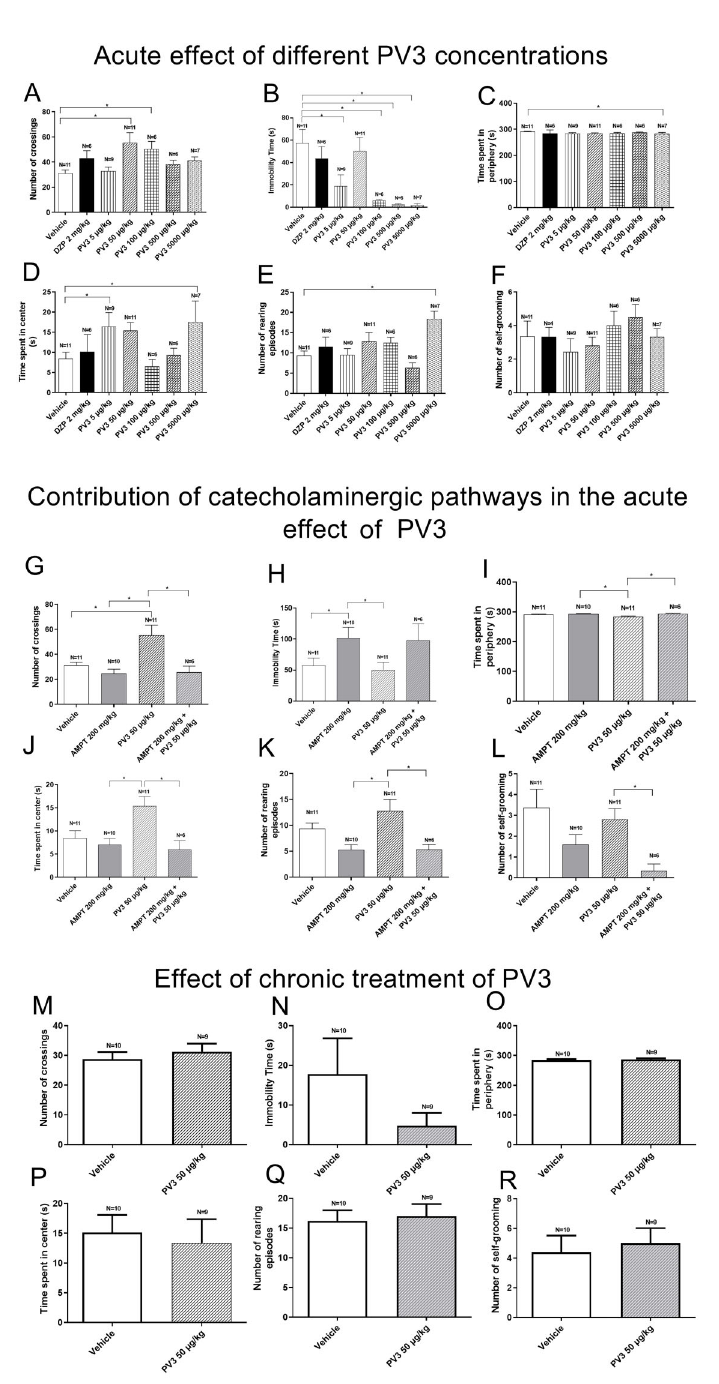
Figure 2. Effect of acute PV3 injection on locomotion/exploration during open fi eld tests ( A – F ). Involvement of catecholaminergic pathways ( G – L ). Effect of chronic treatment with PV3 ( M – R ). Data are reported as means ± SE. *P o 0.05 (ANOVA or t -test). DZP: diazepam; AMPT: